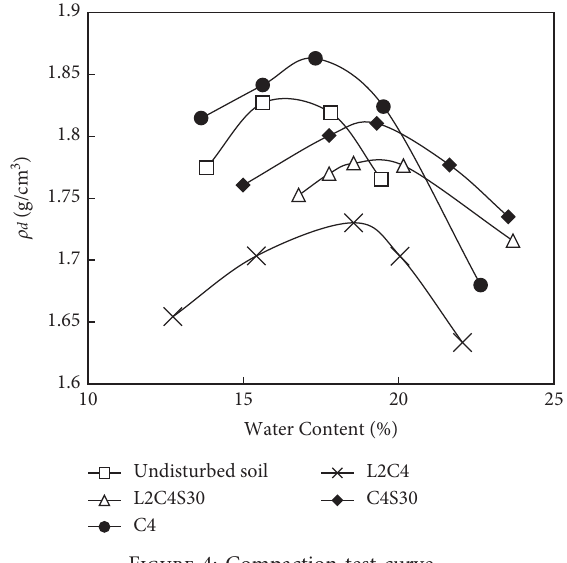
Figure 4: Compaction test